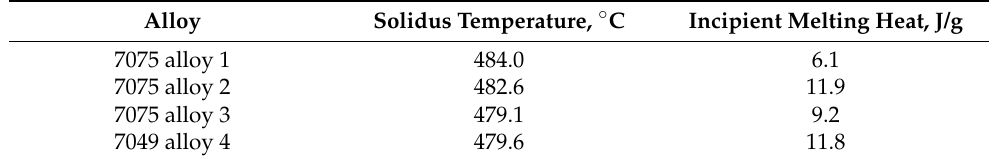
Figure 1. DSC curves of alloys in the as-cast state. Table 3. DSC test results of as-cast alloys.